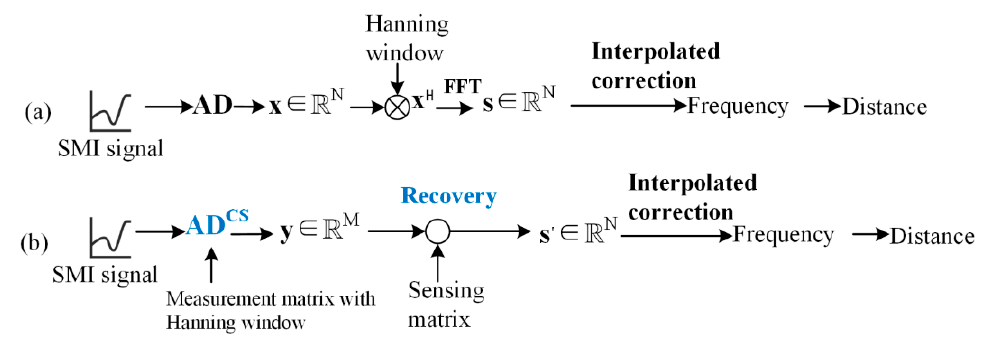
Figure 1. Block diagrams for SMI distance measurement: ( a ) Traditional method; ( b ) CS method.